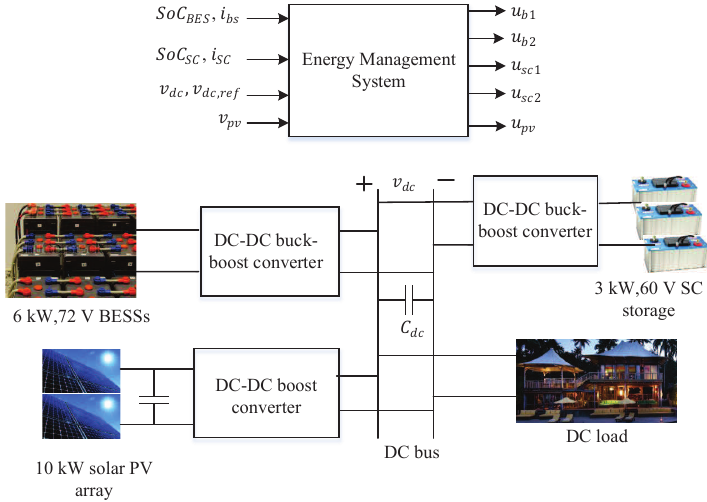
Figure 1. Configuration of the proposed Islanded DC